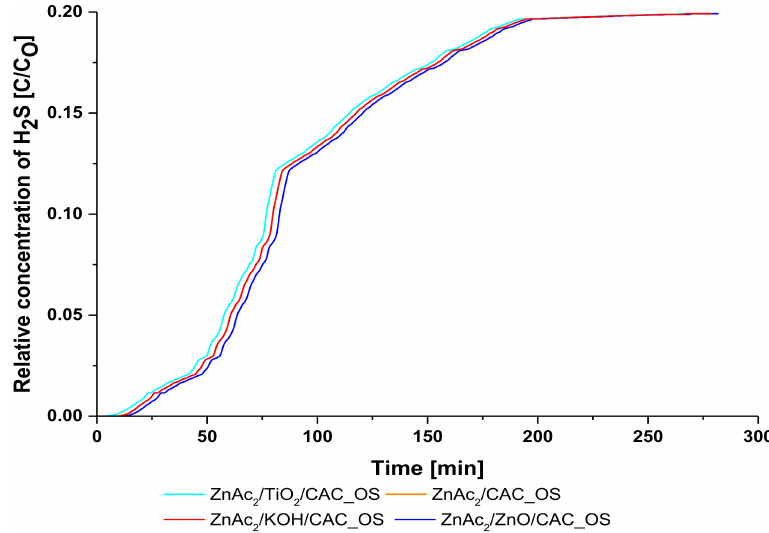
Figure 4. Relative concentration of H 2 S profile for CS/CAC_WS adsorbents.